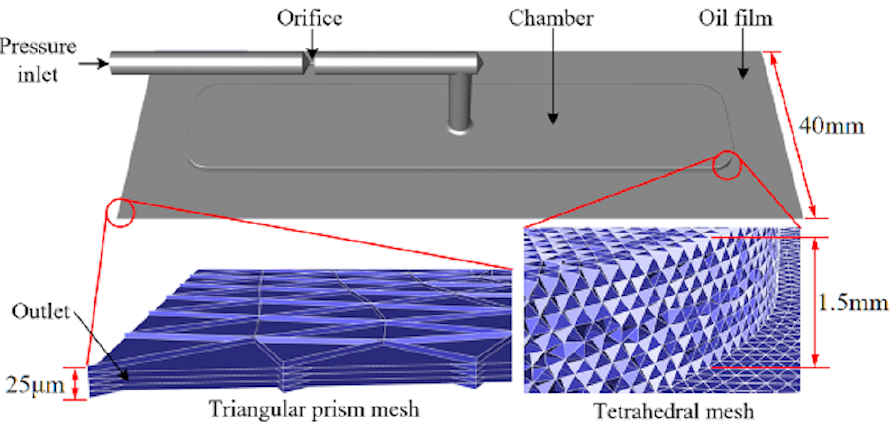
Figure 4. Fluid domain model and grid detail